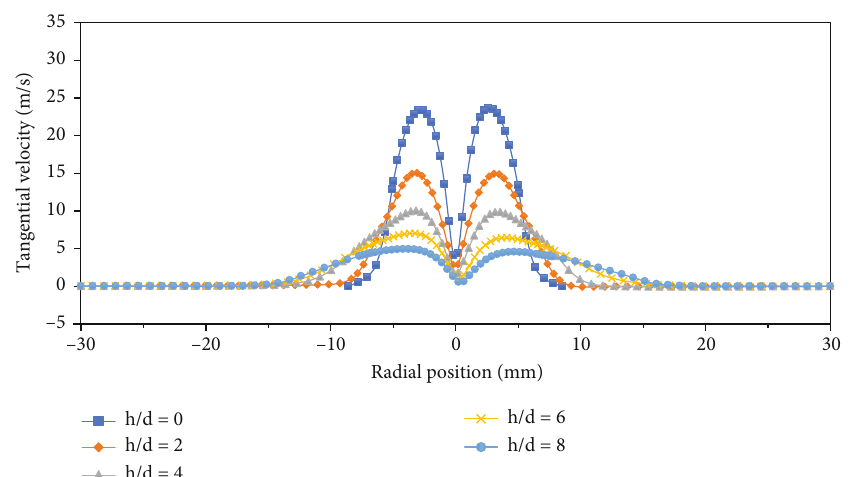
Figure 10: Development law of tangential velocity of